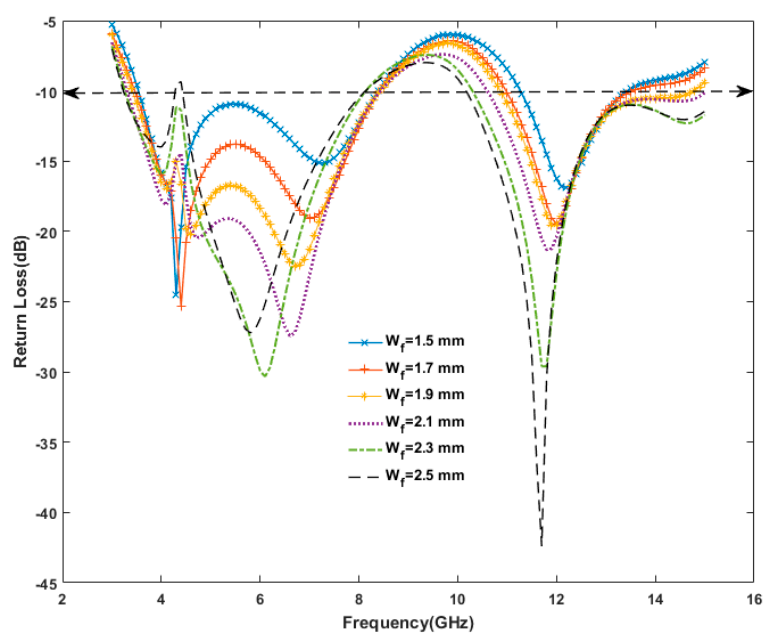
Figure 2. Study of variation on feed width of textile antenna on the basis of return loss plot.